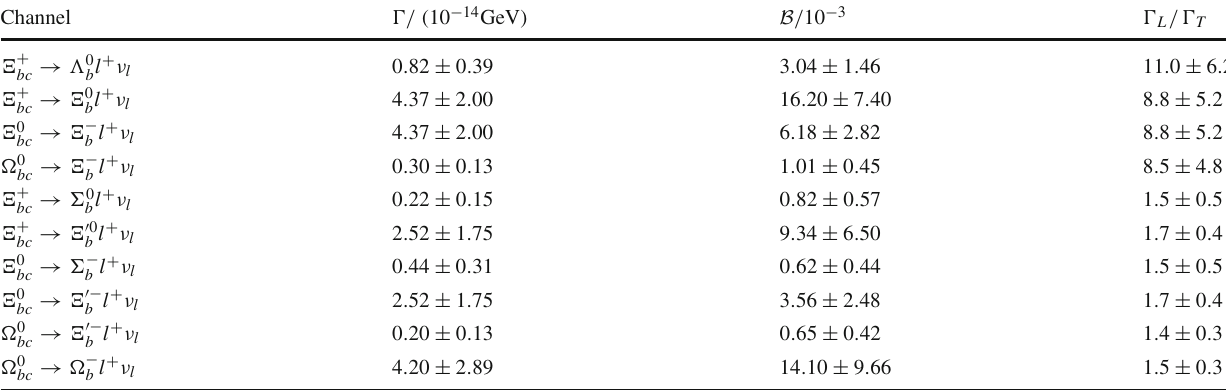
Table 17 Same as Table 15, but for the charm decay of bottom–charm baryons Channel